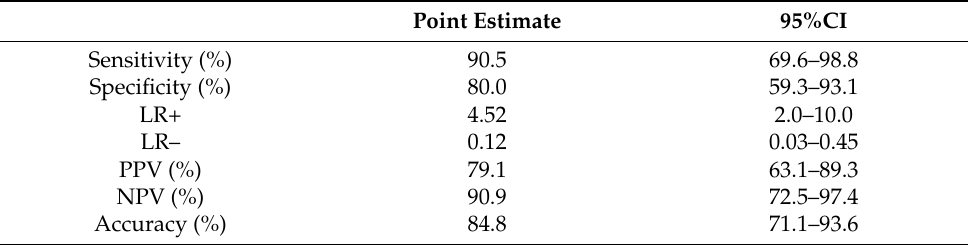
Table 2. Diagnostic test evaluation of the post-exercise tricuspid regurgitation velocity > 3.4 m/s.